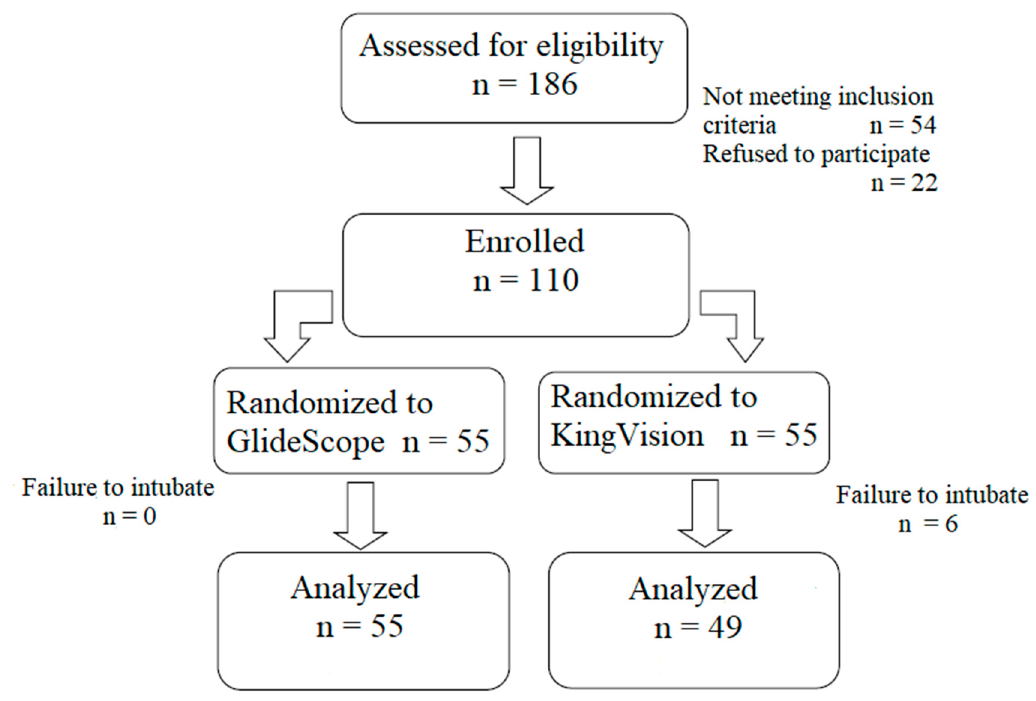
Figure 3. CONSORT 2010 flow diagram of the study.